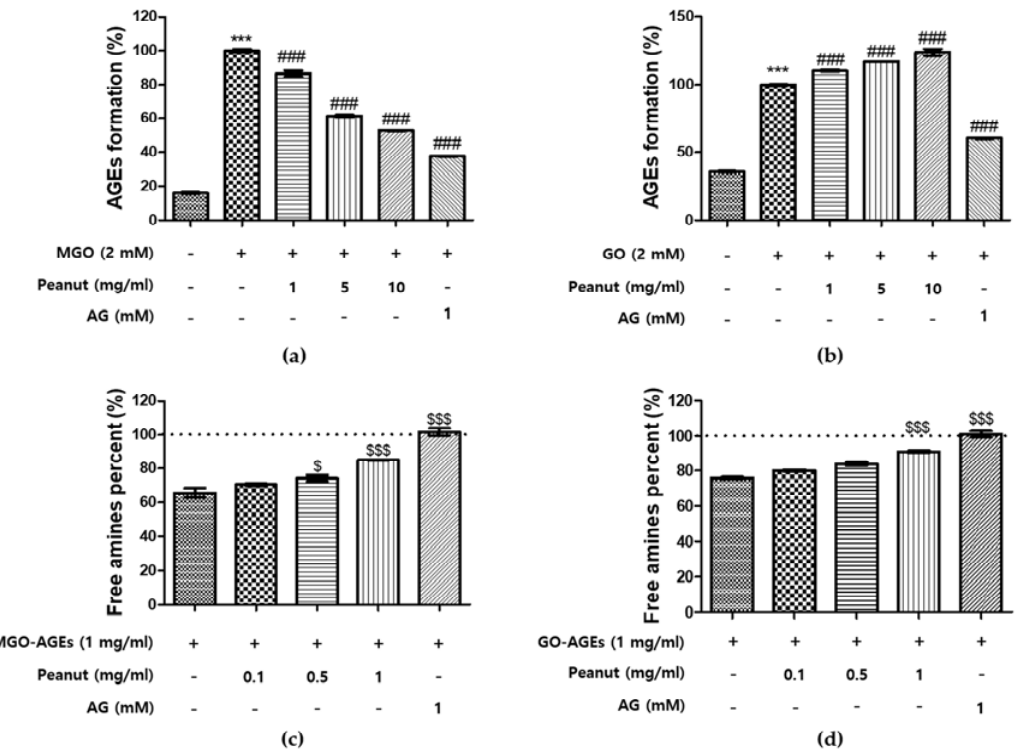
Figure 1. The effect of peanut extract on methylglyoxal (MGO) ‐ induced glucotoxicity. The effects of peanut extract on in vitro advanced glycation end product (AGE) formation was examined using an AGE formation assay: MGO ‐ mediated AGE formation ( a ); and glyoxal (GO) ‐ mediated AGE formation ( b ). Bovine serum albumin (BSA; 5 mg/mL) was incubated with 2 mM MGO or GO in the presence or absence of each sample in phosphate ‐ buffered saline for seven days. The AGE ‐ breaking ability of peanut extracts was evaluated by breaking of: MGO ‐ BSA ( c ); and GO ‐ BSA ( d ), using the TNBS assay. The baseline frequency of BSA ‐ free amines is represented by the dotted line at 100%. The percentage of each experiment is presented as the mean ± SD of three independent experiments. (*** p < 0.001 vs. control; ### p < 0.001 vs. MGO or GO treatment only; $ p < 0.05 and $$$ p < 0.001 vs. MGO ‐ or GO ‐ BSA).